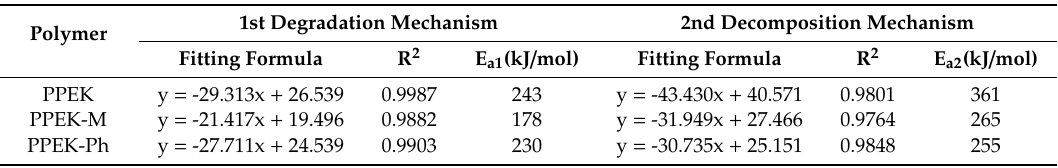
Table 4. Activation energy of the PPEKs determined by Kissinger’s method.